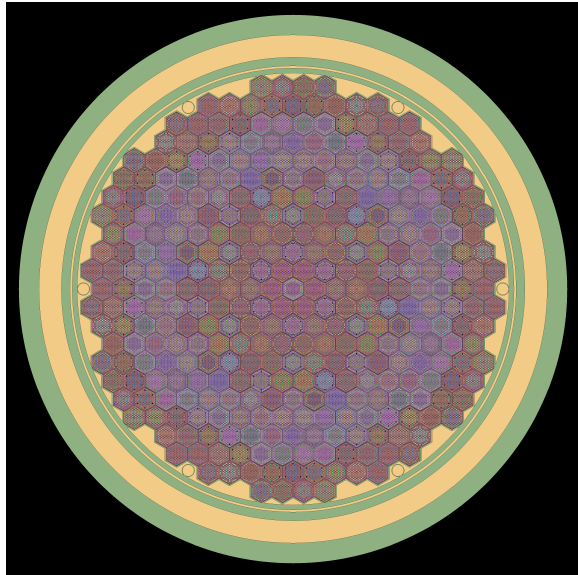
Figure 1. Reactor critical fullcore model